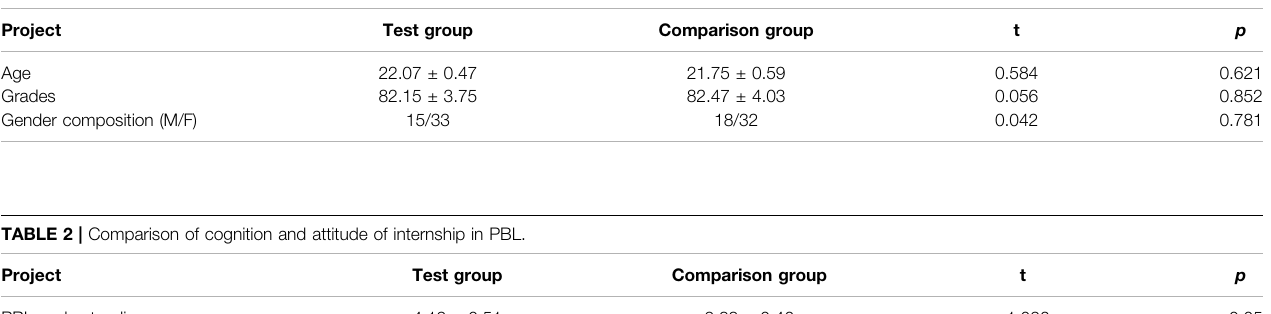
TABLE 1 | Comparison of two basic data.